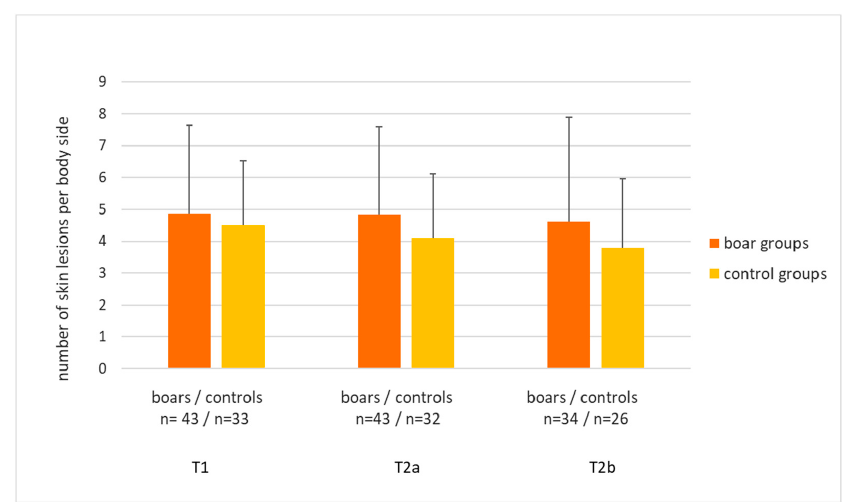
Figure 4. Average numbers of skin lesions on one body side in groups of boars (n = 43) and of barrows or gilts (n = 33) at the three points in time ((T1: mean pig weight around 80 kg; T2a: first pigs